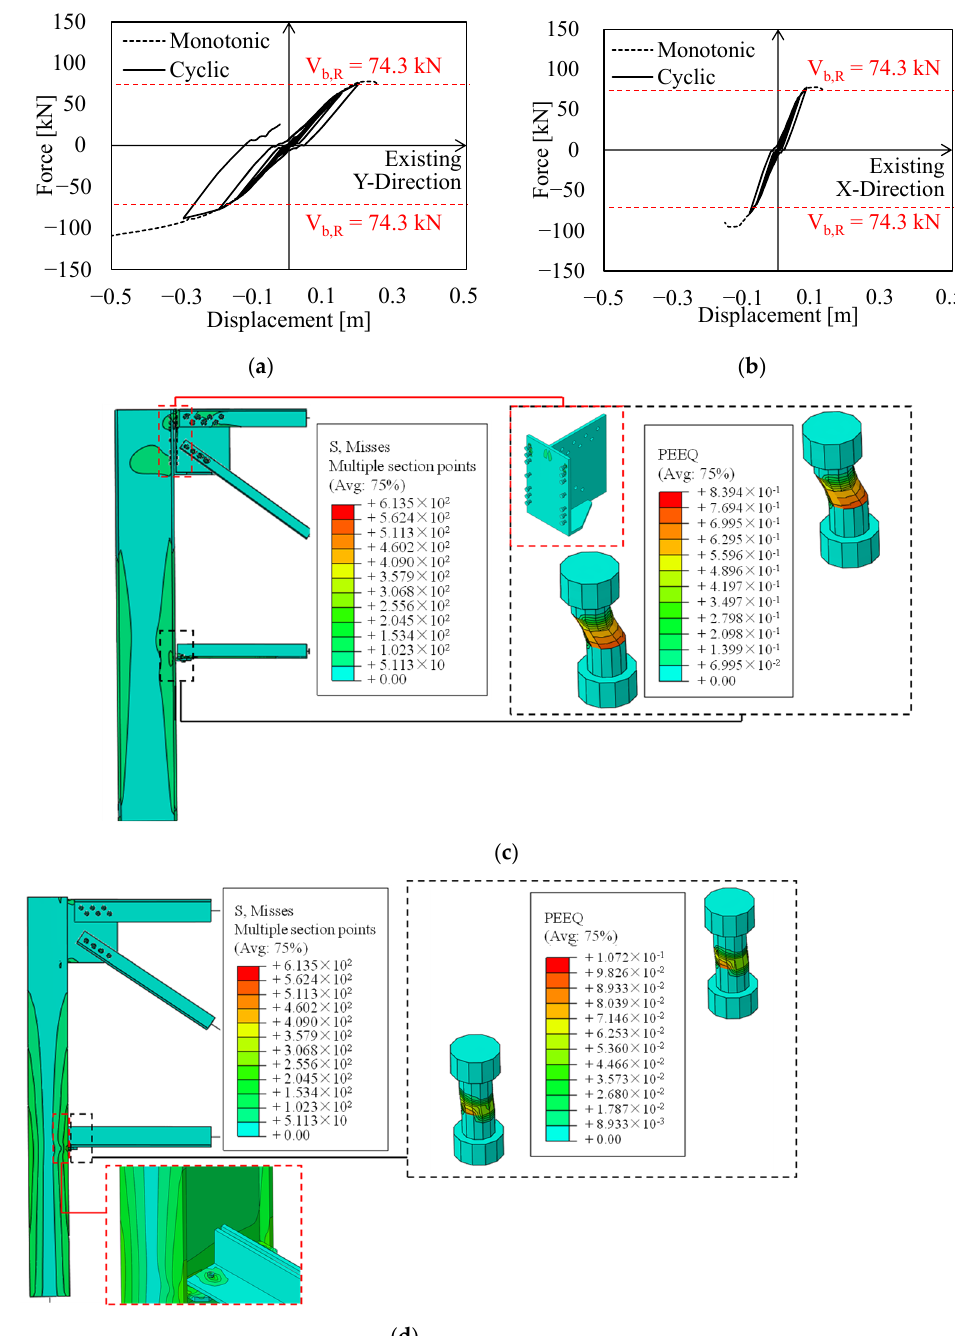
Figure 11. Local performance of existing MR truss connections in terms of base shear vs. displacement curves and distributions of MISES and PEEQ. ( a ) Base Shear vs. Displacements (X); ( b ) Base Shear—Displacements (Y); ( c ) Von Mises and PEEQ distribution of MR truss in X direction under hogging actions; ( d ) Von Mises and PEEQ distribution of MR truss in Y direction under hogging actions.